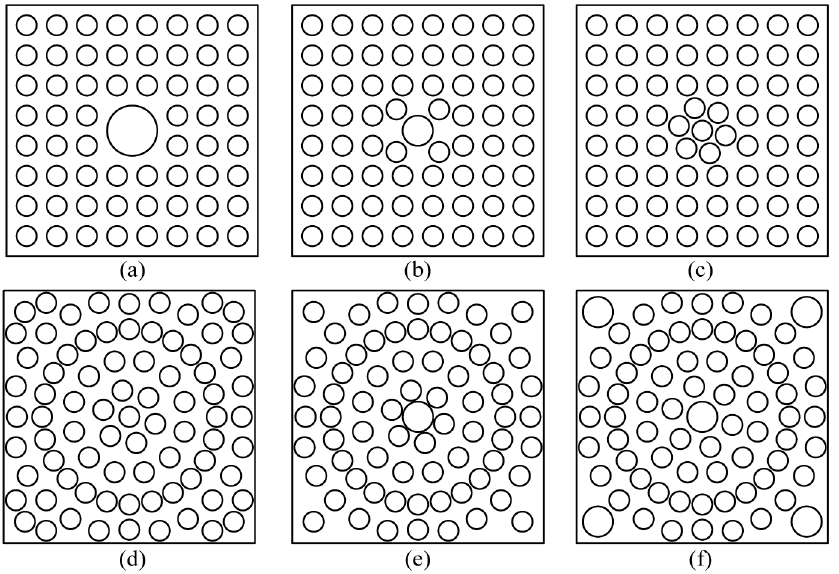
Figure 3. Heating tube and rectifier orifice plates with different structures and parameters. ( a ) Rec- tangular arrangement, center aperture is 80 mm, corner aperture is 60 mm, and other apertures are 40 mm; ( b ) rectangular arrangement, center aperture is 60 mm, corner aperture is 40 mm, and other apertures are 40 mm; ( c ) rectangular arrangement, center aperture is 40 mm, corner aperture is 40 mm, and other apertures are 40 mm; ( d ) circular arrangement, center aperture is 40 mm, corner aperture is 40 mm, and other apertures are 40 mm; ( e ) circular arrangement, center aperture is 60 mm, corner aperture is 40 mm, and other apertures are 40 mm; ( f ) circular arrangement, center aperture is 60 mm, corner aperture is 60 mm, and other apertures are 40 mm.